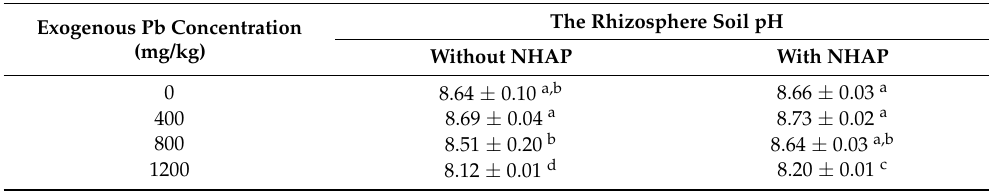
Table 3. Effects of NHAP on rhizosphere soil pH. The different letters in the table represent significant differences between treatments at p <